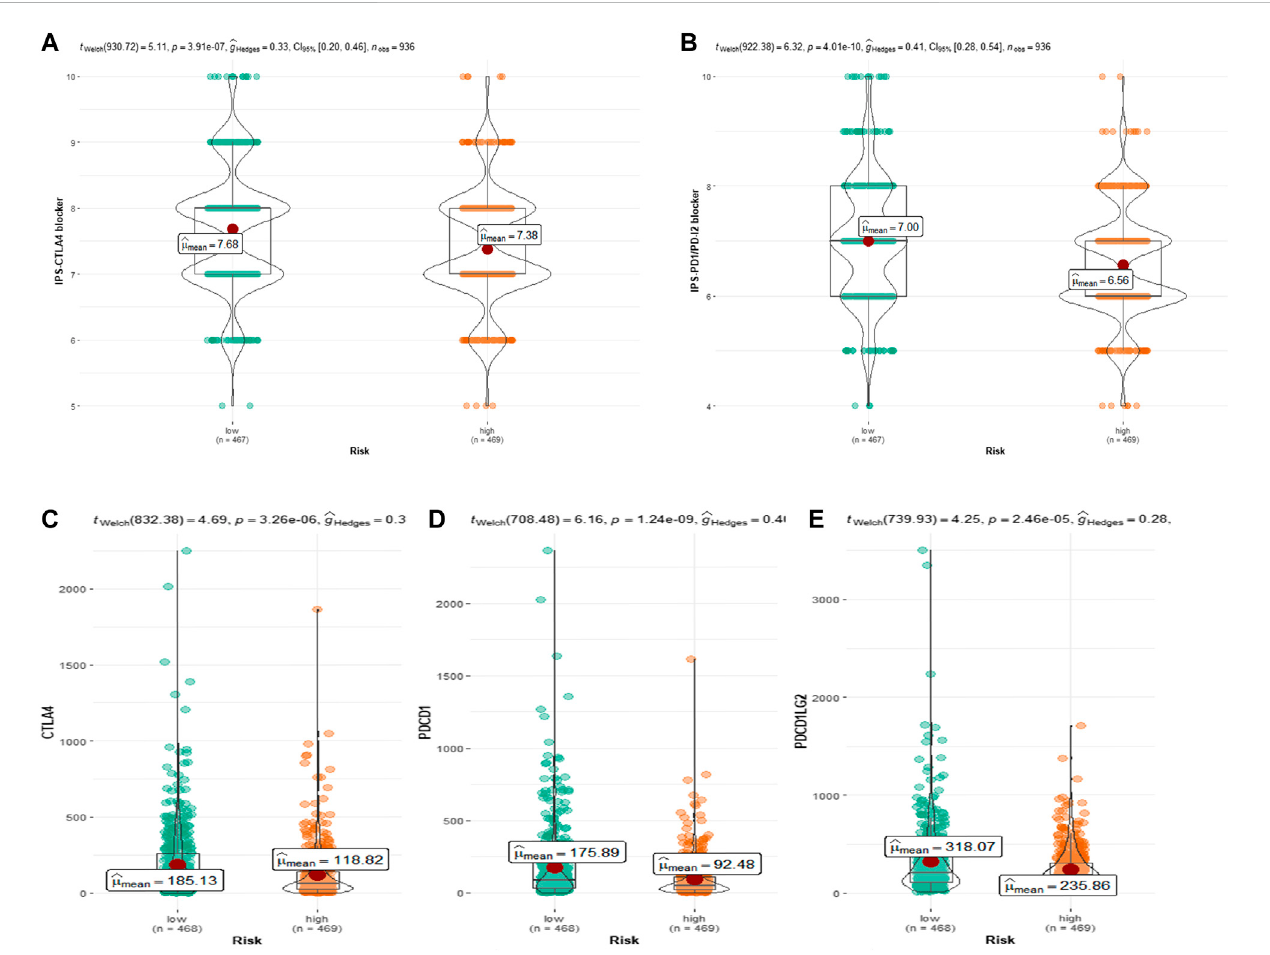
FIGURE 8 (A) RelativeprobabilityofresponsetoCTLA-4treatmentinlow-riskandhigh-riskgroups. (B) RelativeprobabilityofresponsetoPD-1/PD-L2treatmentin low-risk and high-risk groups. Expression of (C) CTLA-4, (D) PD-L1 and (E) pdcd1LG2(PD-L2) in low- and high-risk